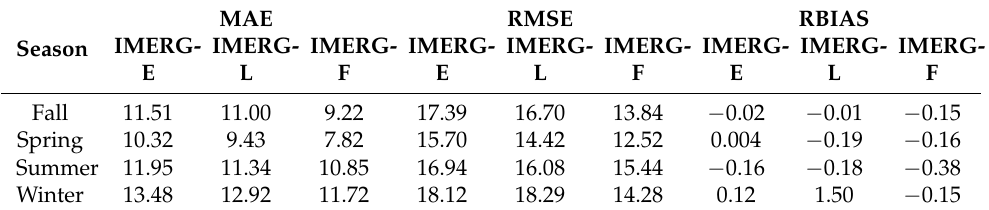
Figure 5. CC values for each season based on the seasonal evaluation. Table 5. Error and BIAS indices based on the seasonal